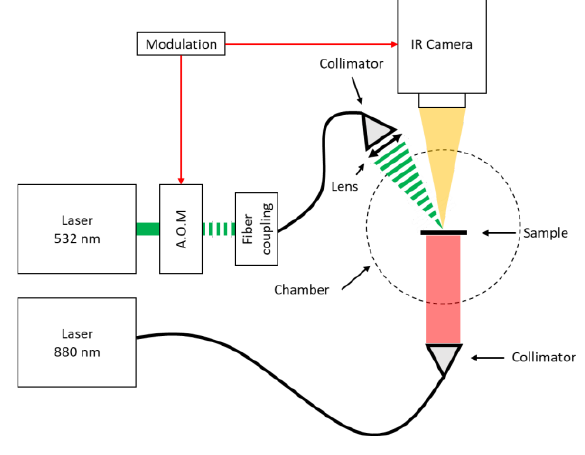
Fig. 3. Schematic of infrared microscope setup